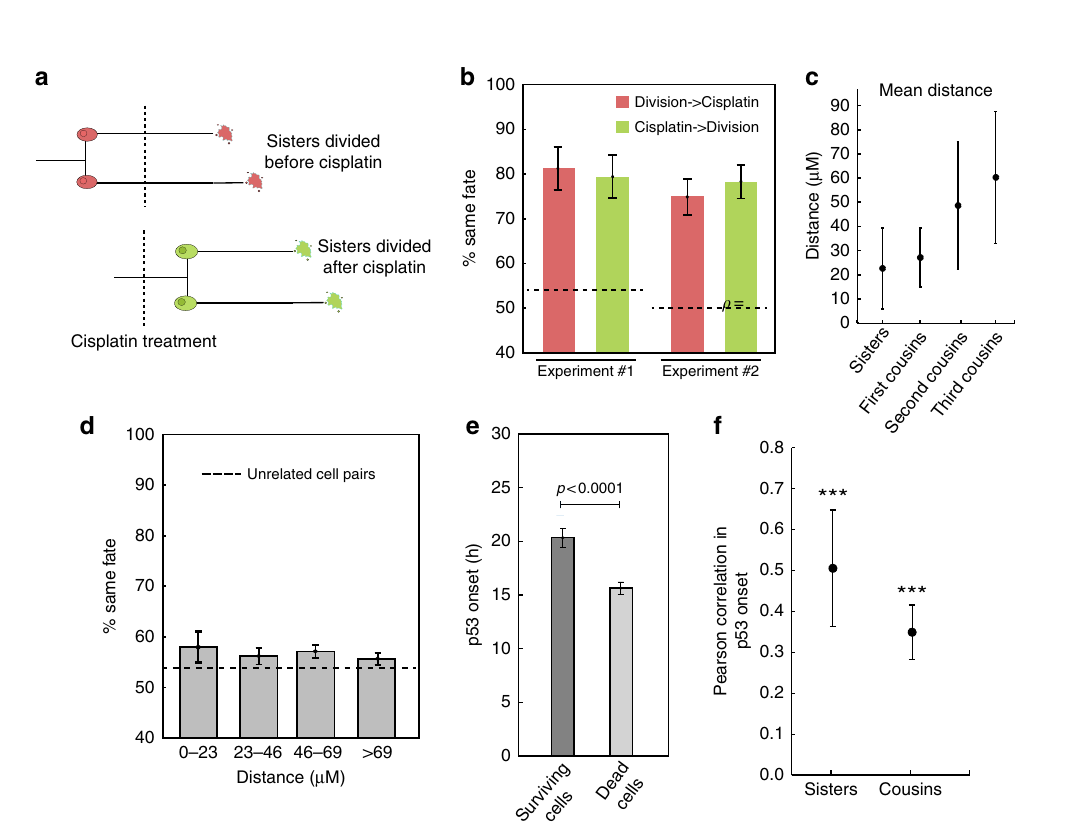
Fig. 2 Cell fate and p53 dynamics are correlated in sisters and cousins. a Sister cell pairs were divided into two groups: those that divided before or after cisplatin treatment. b The percentage of sisters in each group that share the same fate. Experiment #1 N = 61, N = 108, for experiment #2 N = 150, N = 150. The dashed lines represent the % of unrelated cells that share the same fate. c Mean distance separating cells when cisplatin was added by relationship N = 61, 259, 414, 533. The centroid of the nucleus was used for the location of each cell. Euclidean distances were computed for every pair of cells. d % of unrelated cell pairs that share the same fate grouped by distance separating cells when cisplatin was added. N = 243, 896, 1341, 1791. Sister cells were on average 23 μ M apart. The dashed line is the same as in b Error bars for c , d are standard deviation. e p53 onset in apoptotic cells was faster than in surviving cells. N = 144, 250. Error bars represent standard error of the mean. Signi fi cance by t -test ( f ) p53 onset was correlated among sister and cousin cells. *** P < .0001. See methods for calculations of signi fi cance